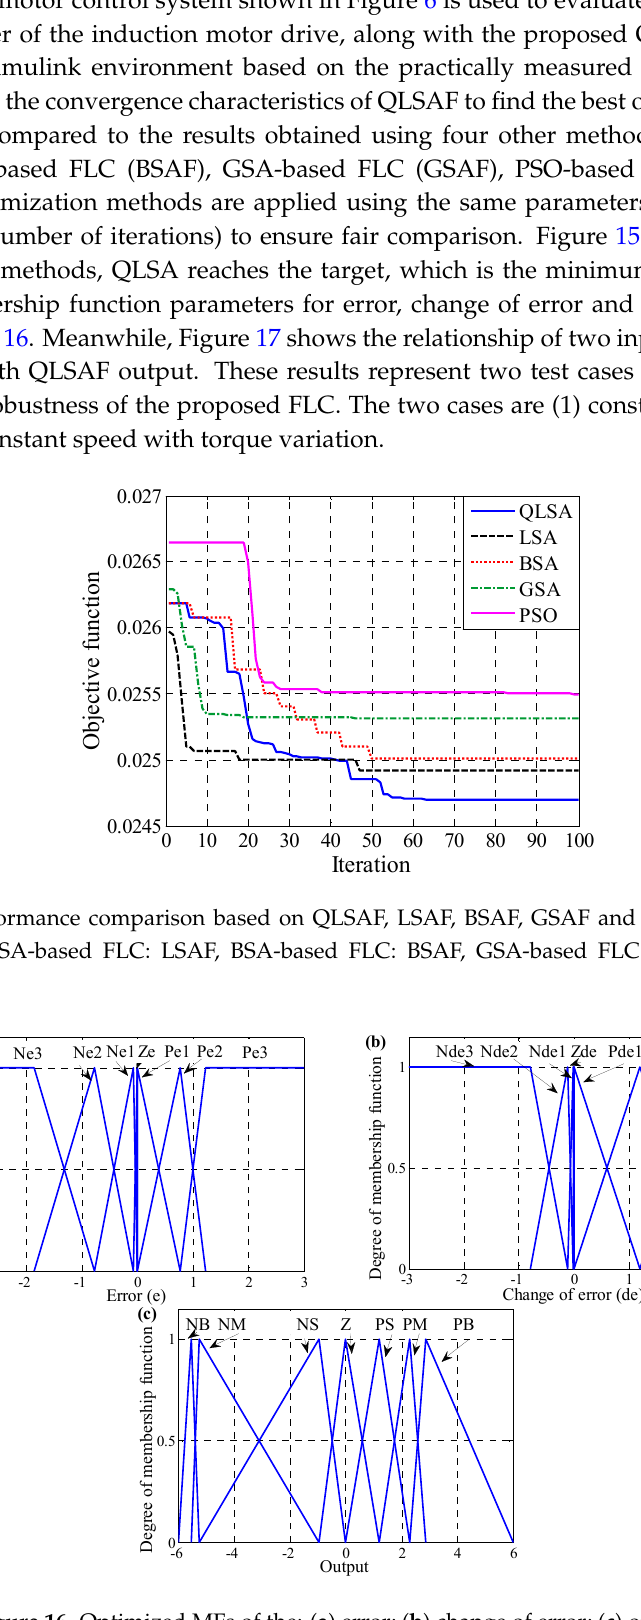
Figure 16. Optimized MFs of the: ( a ) error; ( b ) change of error; ( c ) output.